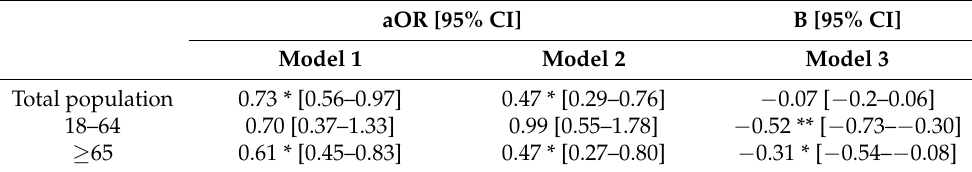
Table 4. Impact of SARS-CoV-2 vaccination on COVID-19 patients in 2021 (n =